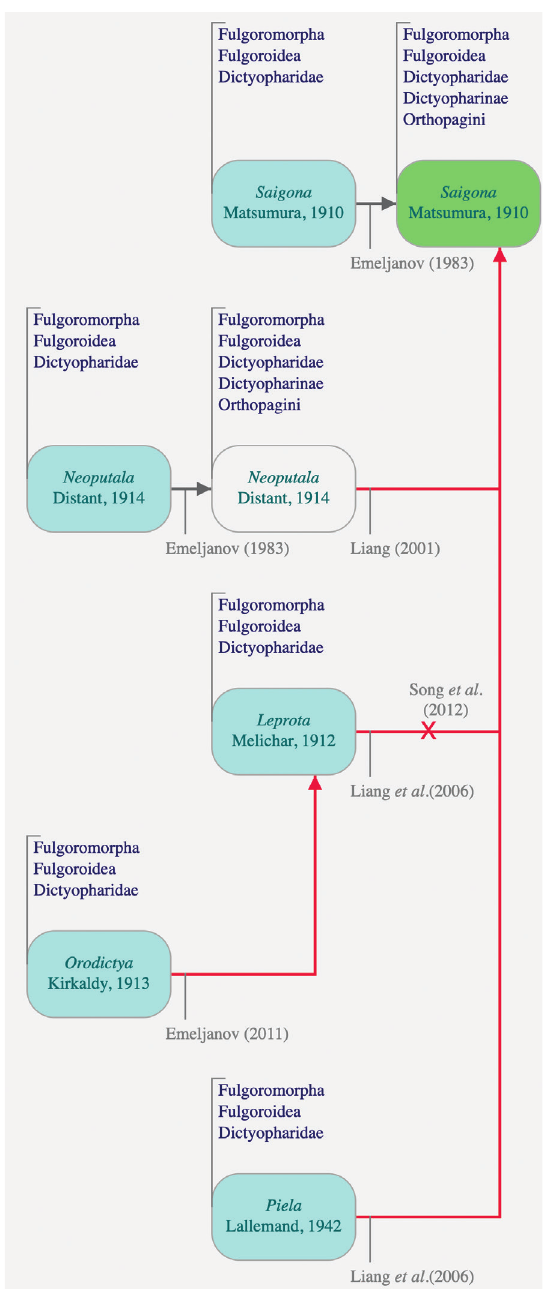
Figure 1. Taxonomic history of the genus Saigona Matsumura, 1010 (uploaded from Bourgoin 2021). For each synonymized genus, their protonyms are in blue boxes, and the current valid name of the genus is in green. Red vertical arrows illustrate synonymy and the red cross the status revivisco of the genus Leprota Melichar,